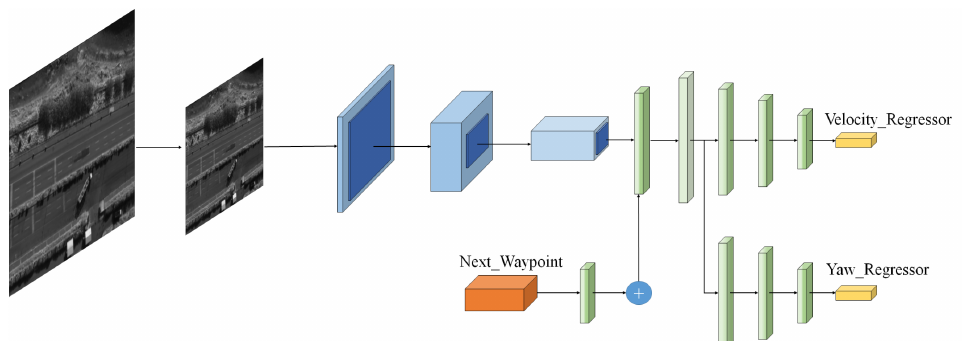
Figure 4. The lightweight multitask deep learning model to achieve real-time computational capacity in a drone.